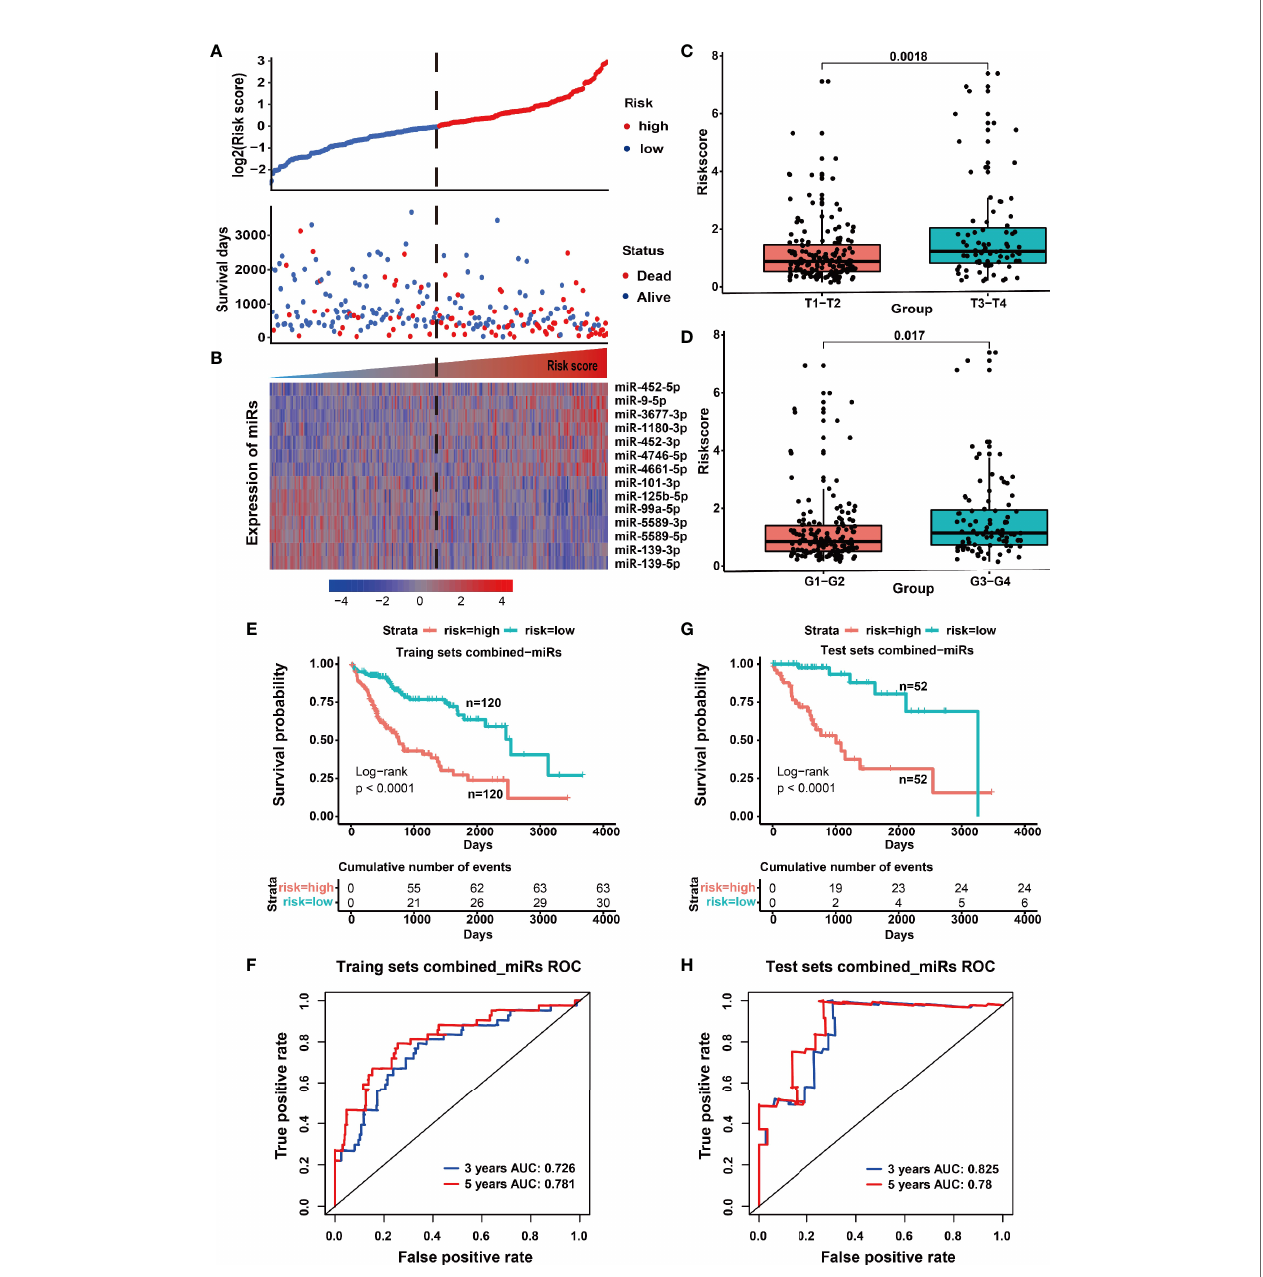
FIGURE 3 | Model risk signature based on 14 miRNAs was used to predict the outcome of patients. (A) The distribution map of patient deaths at different risk values. (B) The heat map of prognostic miRNA expression in patients with different risk values. (C) The risk difference for patients with different T grades (extent of the primary tumor). (D) The risk difference for patients with different G grades (histopathological degrees). (E) Survival curves of the high and low risk groups in the training set. (F) ROC curve of signatures based on 14 miRNAs in the training set. (G) Survival curves of the high-risk and low-risk groups in the test set. (H) ROC curve of the 14 miRNA-based signatures in the test